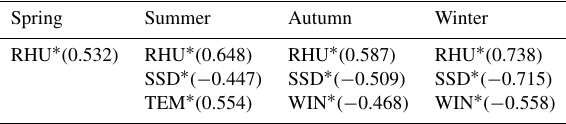
Table 2. Major meteorological factors strongly correlated with sea- sonal PM 2 . 5 concentrations in Beijing (Chen et al., 2017). Spring Summer Autumn